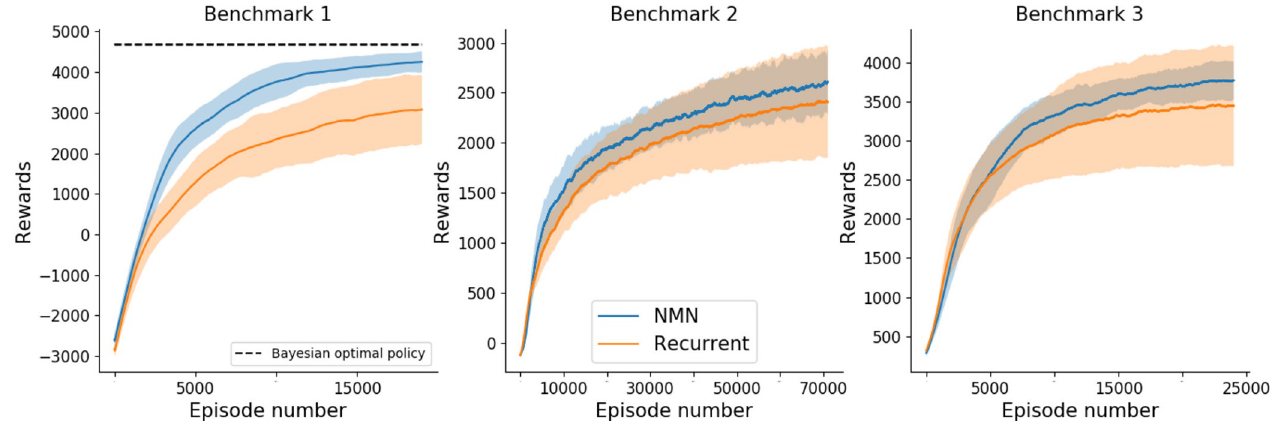
Fig 6. Mean ( ± std in shaded) sum of rewards obtained over 15 training runs with different random seeds with respect to the episode number. Results of benchmark 1,2 and 3 are displayed from left to right. The plots are smoothed thanks to a running mean over 1000 episodes.